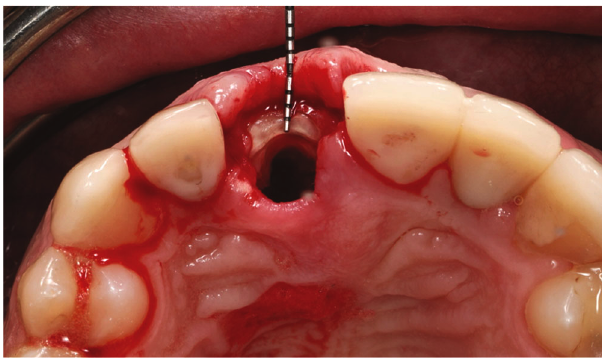
Figure 3: Virtual implant placement planning — superimposition of future implant and the root.